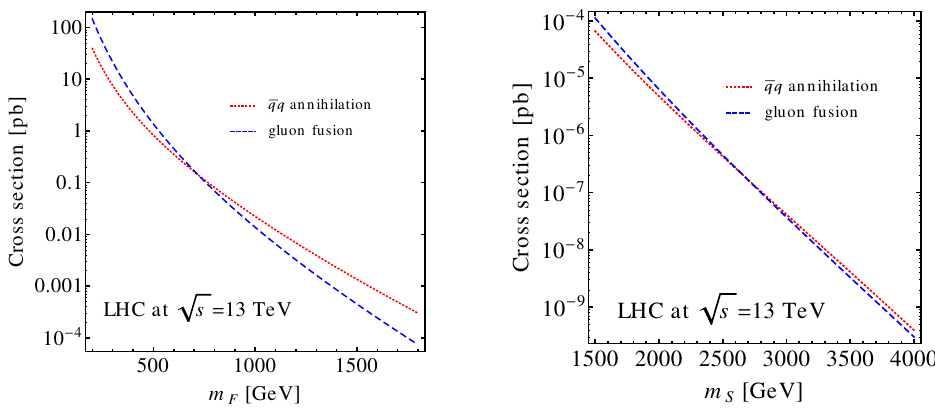
√ s = 13 TeV of the